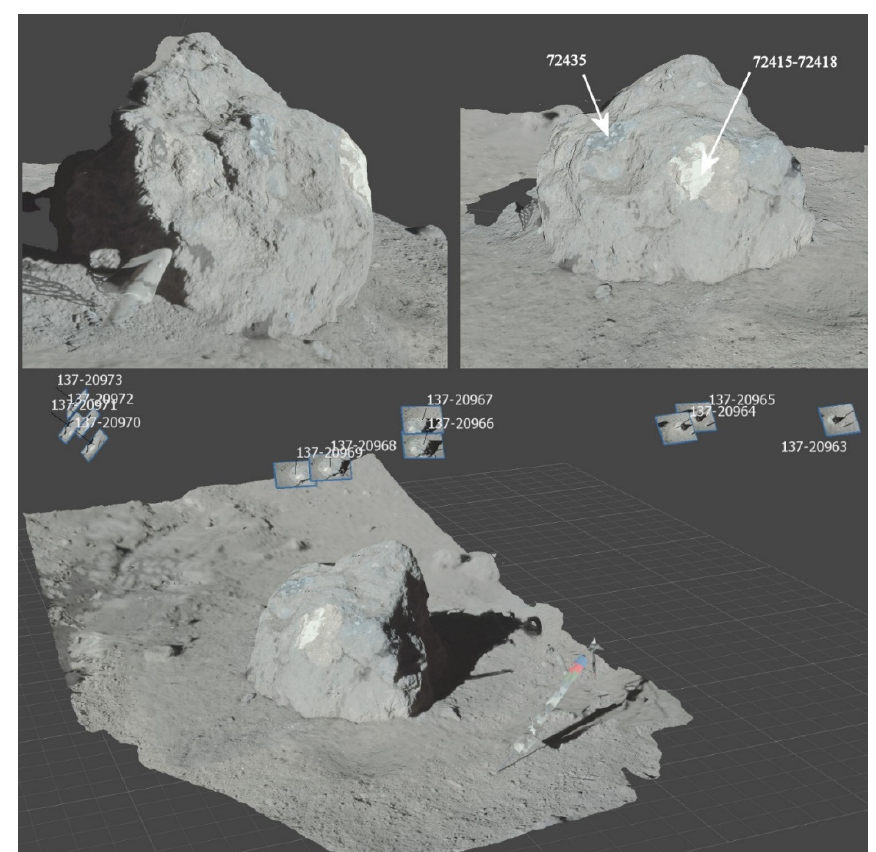
Figure 10. Photogrammetric reconstruction (textured 3-D model) of the 40-cm boulder 3 at Station 2. The location and orientation of the 11 entry Apollo images labeled AS17-137-20963 to AS17-137-20973 as computed by Metashape are indicated by annotated squares in the bottom view. Sample 72435 (matrix) was extracted from the blue-gray patch. Samples 72415-72418 were extracted from a large dunite clast (white patch). These sampling areas are well visible on the texture of the reconstructed boulder.